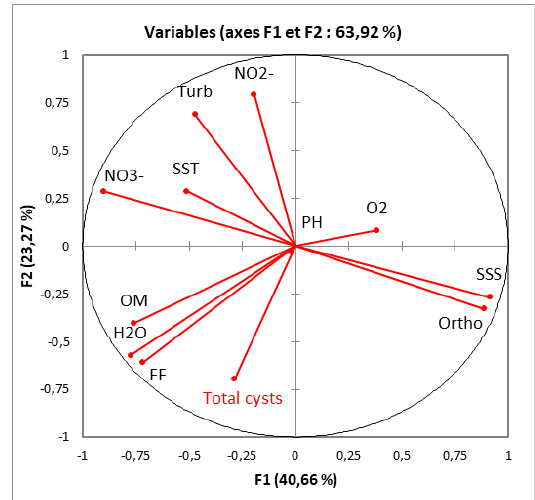
Figure 6 . Distribution (%) of cysts of the major potentially harmful dinoflagellate species recorded in the sediments of Sidi Moussa Lagoon